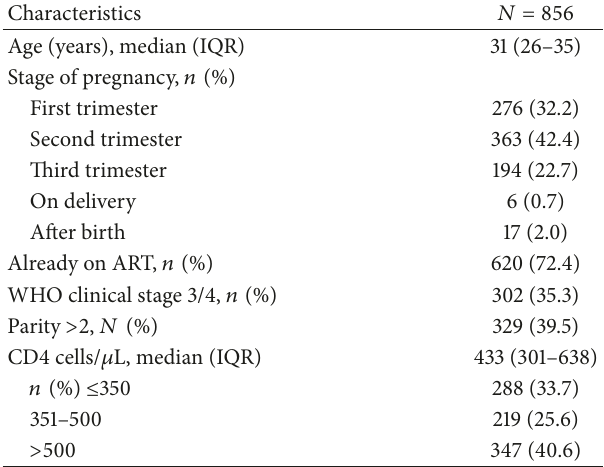
Table 1: Characteristic of pregnant women at enrollment in the integrated HIV-antenatal